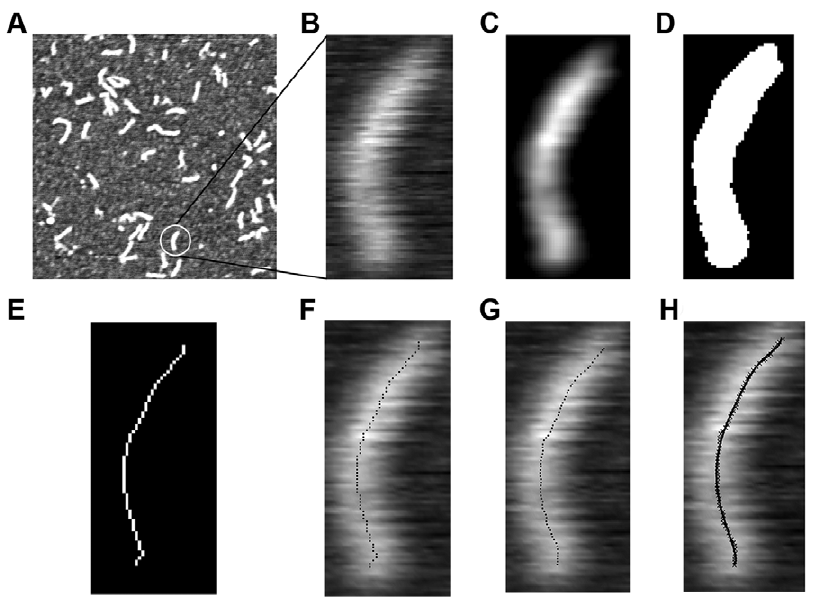
Figure 2. Image processing procedure to extract the molecular contour of a Tm from a typical AFM scan. An a Tm molecule was selected from a typical 512 nm 6 512 nm scan (A) and cropped into a smaller image (B). The image was filtered by a Gaussian box-car filter (C), thresholded (D), and skeletonized into a 1-pixel wide connected contour (E, F). A refined skeleton with coordinates defined at sub-pixel precision was generated by fitting the perpendicular height profiles to a Gaussian function (G), which was then fitted with a 5 th order polynomial. The continuous contour defined by the polynomial conformed very well with the shape of the original molecule (H). Contour length (L c ) and end-to-end length (L e-e ) of the molecule shown were 41.7 nm and 38.4 nm,